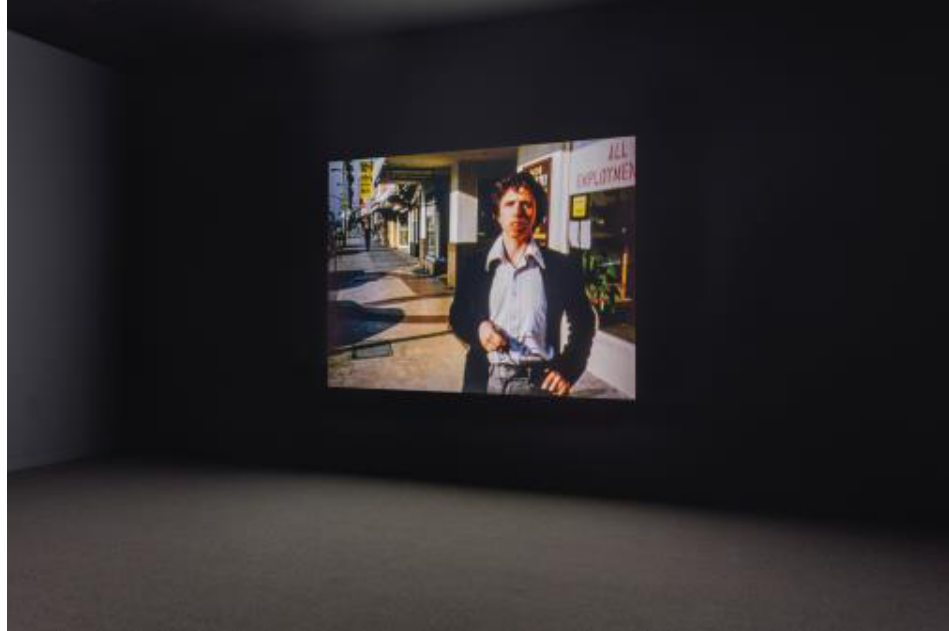
David Lamelas, The Desert People, 1974. Still of the anthropologist’s testimony. 16mm film transferred to DVD, color, sound, 44:09 min. Installation view. Hammer Museum, Los Angeles. Purchased through the Board of Overseers Acquisition Fund. Copyright David Lamelas, images courtesy of Maccarone, Sprüth Magers, and Jan Mot.